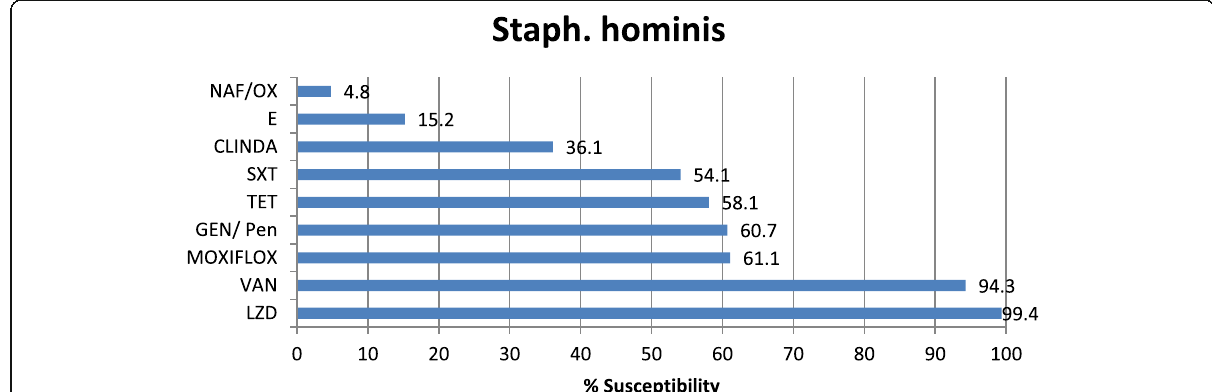
Fig. 6 Antibiotic susceptibility of Gram-positive Staph. hominis . NAF/OX nafcillin/oxacillin, E erythromycin, CLINDA clindamycin, SXT sulfa- trimethoprim, TET tetracycline, GEN/pen gentamycin/penicillin, MOXIFLOX moxifloxacillin, VAN vancomycin, LZD